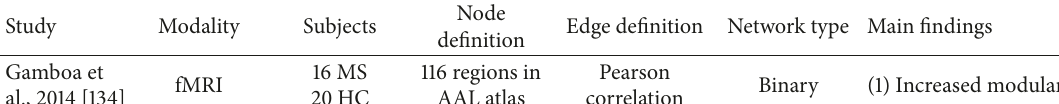
Table 9: Overview of functional brain network studies in